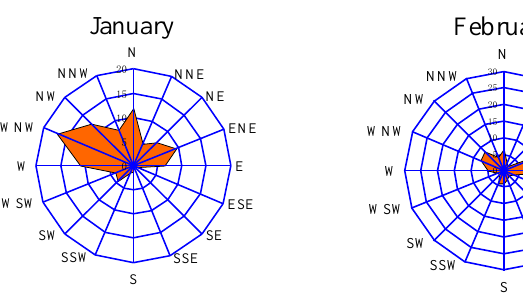
Figure 8. Rose diagrams of wind directions in different months at the Xujiahui